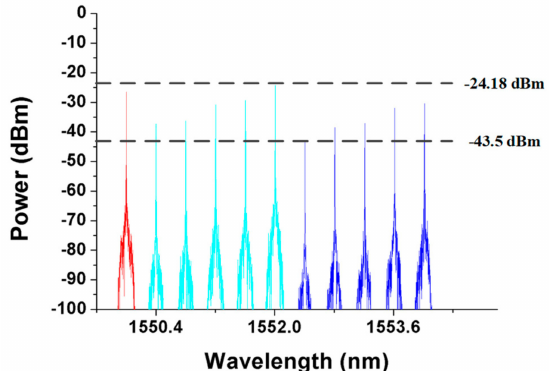
Figure 10. Detection signals received by the CO during the first phase of the second step of the detection